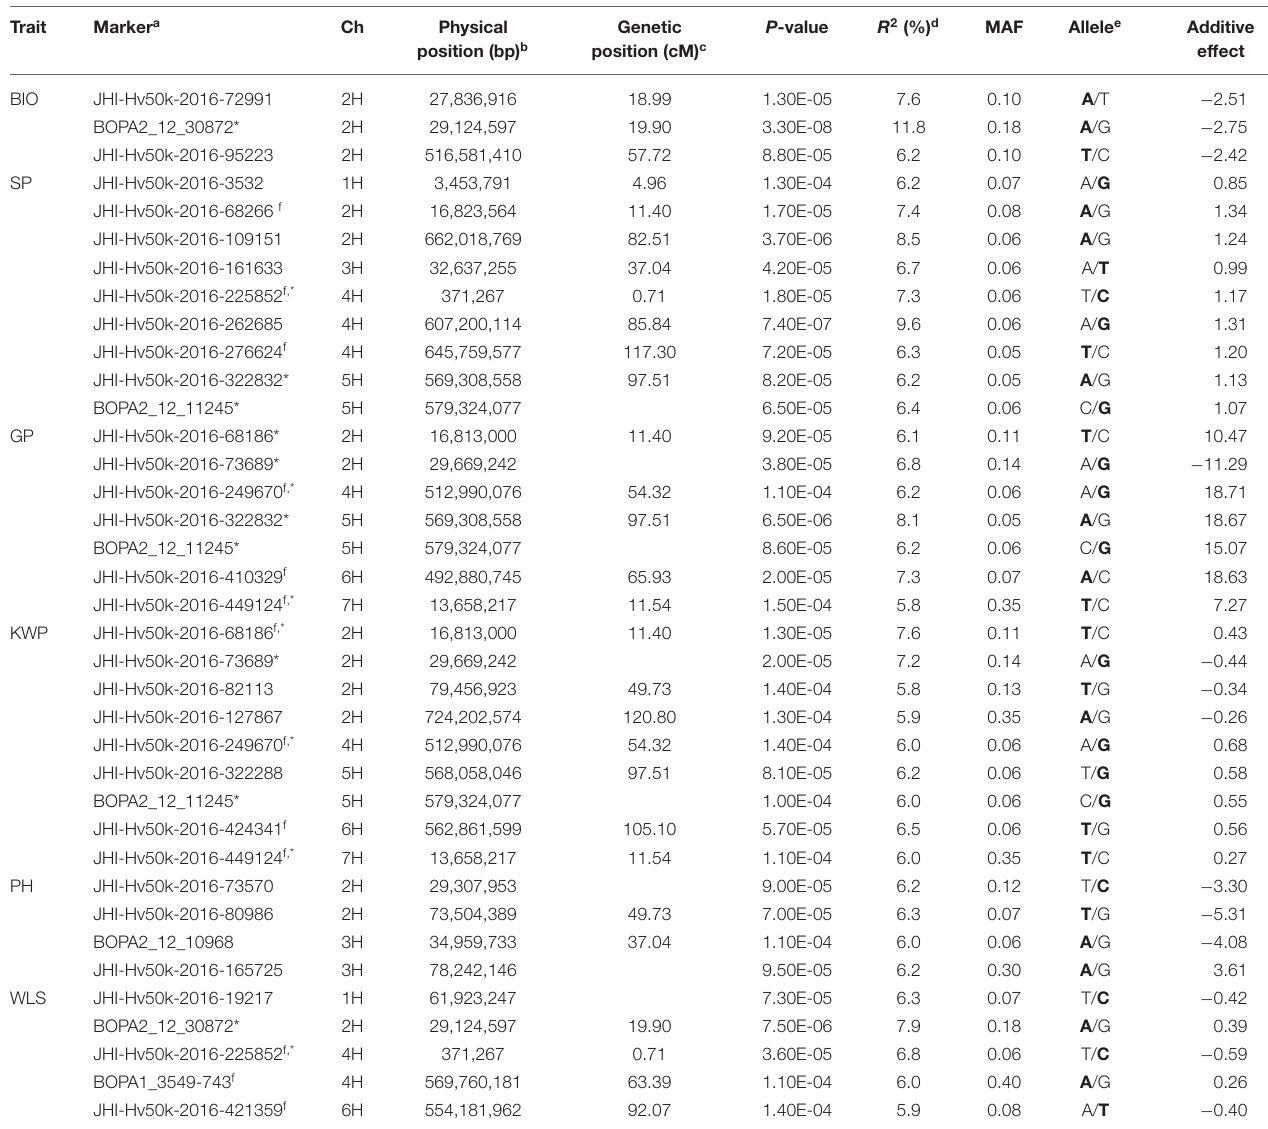
TABLE 4 | List of significant ( P < 1.6 × 10 − 4 ) marker-trait associations detected by GWAS using the MLM (Q + K) model in JMP Genomics and favorable alleles (bold) for assessed traits in the overall waterlogging treatment conditions. Trait Marker